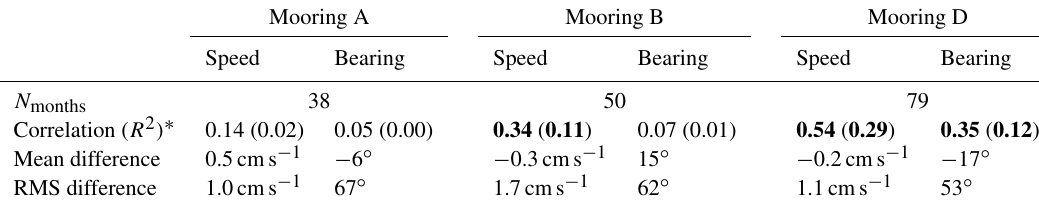
Table 1. Comparison between the satellite-derived geostrophic currents and in situ currents measured at three BGEP moorings. Mooring A Mooring B Mooring D Speed Bearing Speed Bearing Speed Bearing N months 38 50 79 Correlation ( R 2 ) ∗ 0.14 (0.02) 0.05 (0.00) 0.34 ( 0.11 )